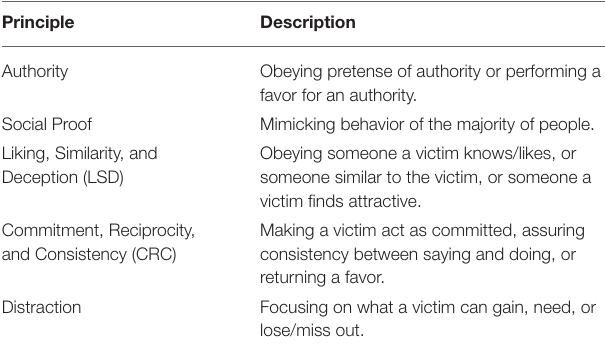
TABLE 2 | Summary of the five newly proposed principles of persuasion that would better represent the psychological vulnerabilities exploited by social engineering cyberattacks (Ferreira et al., 2015).